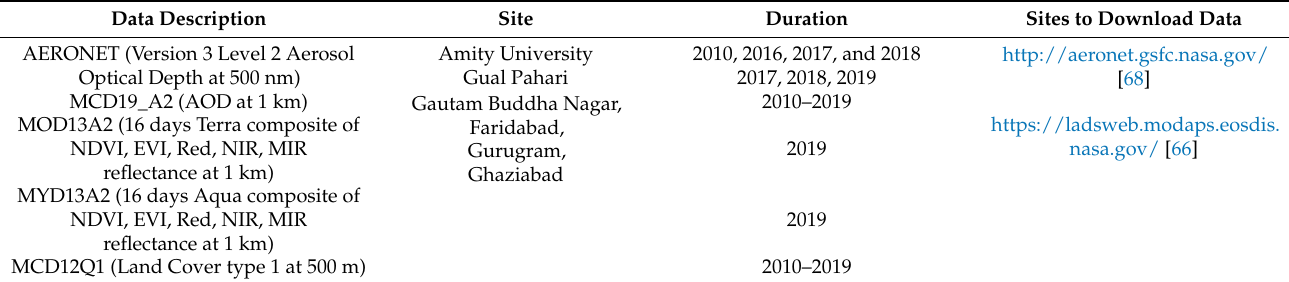
Table 1. Information about the data used in the